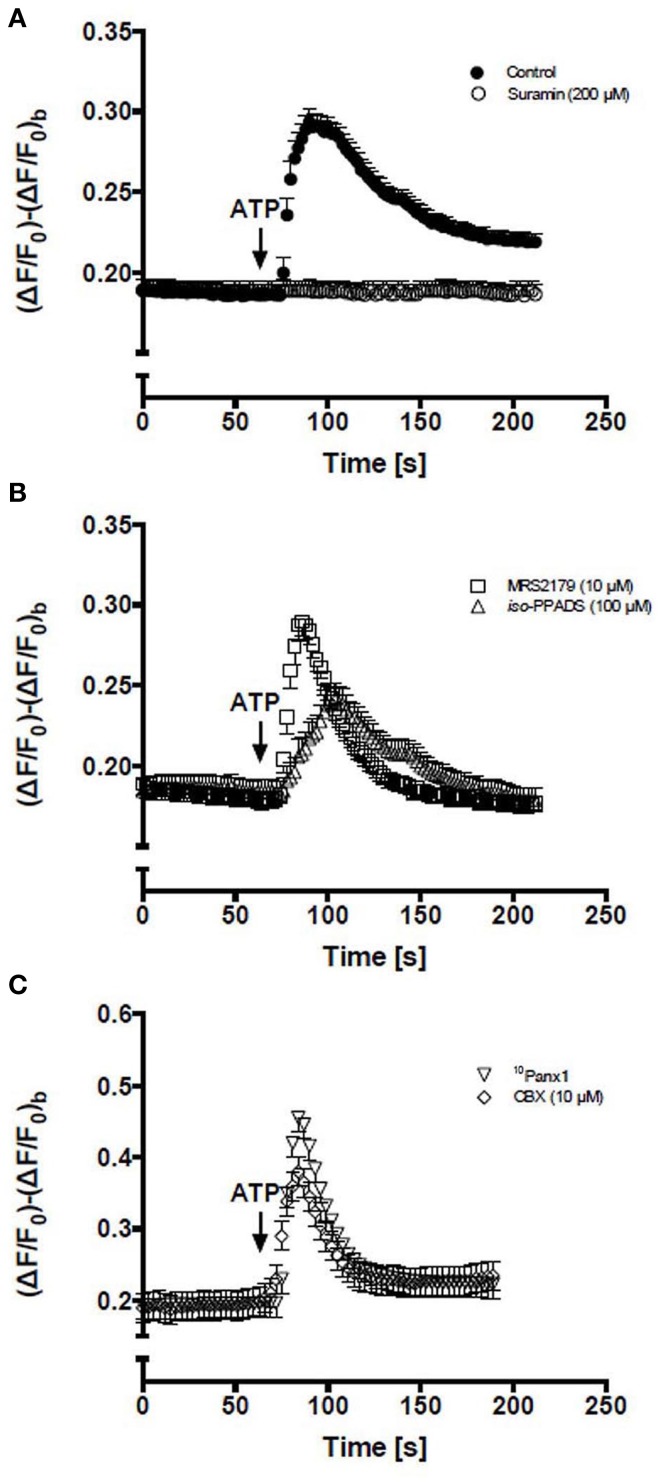
Activation of P2Rs with extracellular ATP elevates intracellular Ca2+ levels in C2C12 RCs. Time course of relative fluorescence changes induced by bath application of 150 μM ATP (arrow) in C2C12 RCs loaded with Fluo-3. (A) Cells were stimulated with 150 μM ATP alone or preincubated (5 min) with 200 μM suramin (a P2Y and P2X receptor antagonist) and then treated with ATP. (B) RCs were preincubated (5 min) with 10 μM MRS2179 or 100 μM iso-PPADS followed by stimulation with 150 μM ATP. (C) RCs preincubated (5 min) with 10Panx1 peptide or 10 μM carbenoxolone (CBX) and then stimulated with ATP. Each point corresponds to the mean ± SEM, n = 3 experiments. At least 10 cells were recorded per experiment.